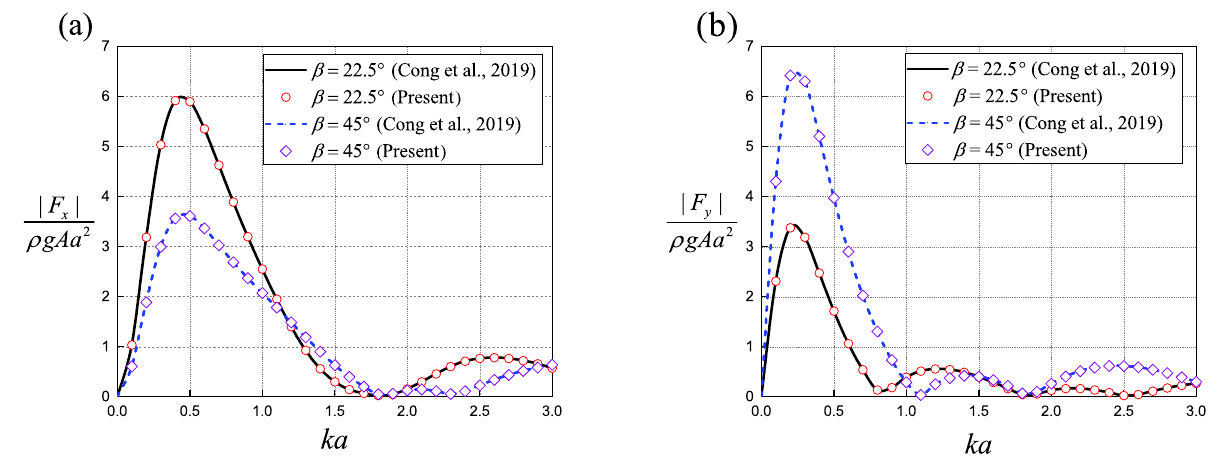
Figure 4. Comparison of the maximum hydrodynamic loads on a porous cylinder near a wall derived by our method and by Cong et al. [30] for b = c = 0, h / a = 5, G 1 = 1, and e / a = 1: ( a ) x direction, ( b ) y